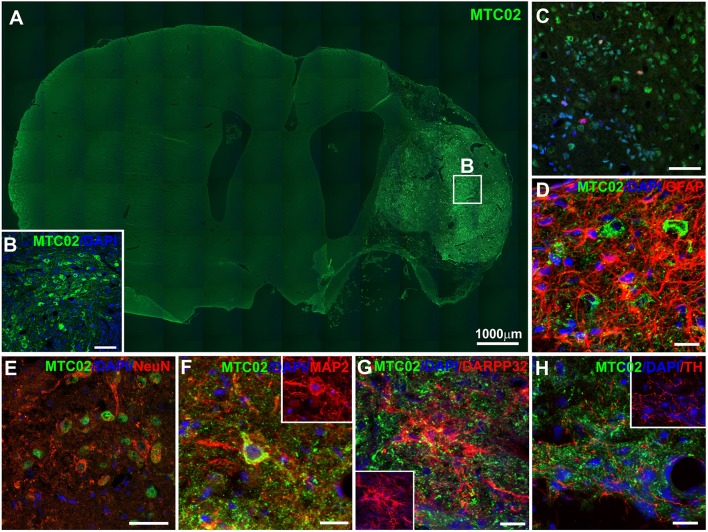
Immunohistochemical staining of ischemic rat brain tissue 4 months after iPSC-NP transplantation. Grafted neural precursors survived and migrated toward the lesion area (A,B), differentiated into NeuN- (E), MAP2- (F), and DARPP32- (G) positive cells, actively integrated into the lesioned host tissue (D,H) and decreased their Ki67 index (C) to 3.2–0.8%.